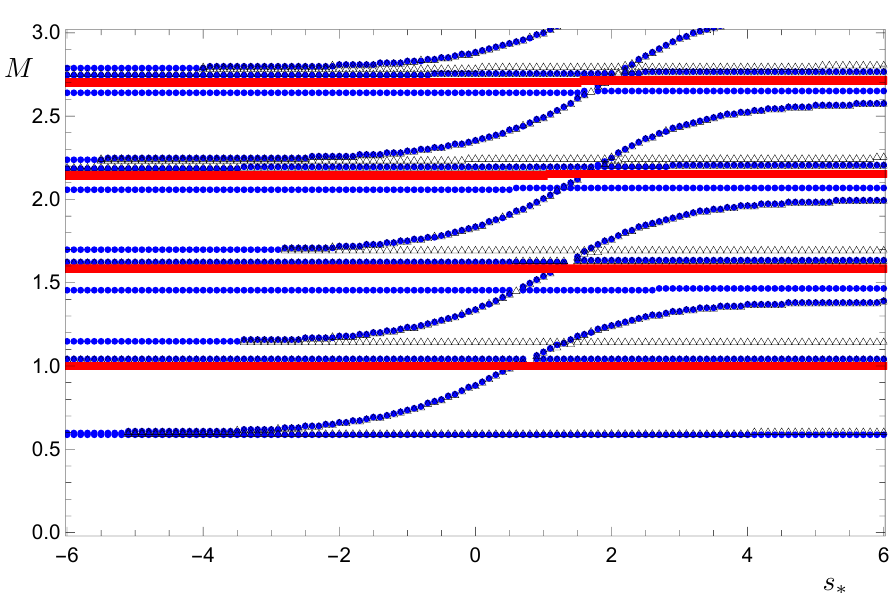
p Figure 5 . Masses M = (cid:0) q 2 of modes in the torus reduction of maximal D = 7 dimensional supergravity, as a function of the parameter s . All masses are expressed in units of the mass of (cid:3) the lightest tensor mode. The (red) squares represent the tensor modes, the (blue) circles are the scalar modes, computed with the complete, gauge-invariant variables, while the (black) triangles are the scalar modes computed by making use of the probe approximation. We notice that in the probe approximation, and for large negative values of s , two of the towers of scalar state become (cid:3) so close to degenerate that in our numerical study we could not resolve them. In the numerical calculations (cid:26) 1 = 0 : 001 and (cid:26) 2 =